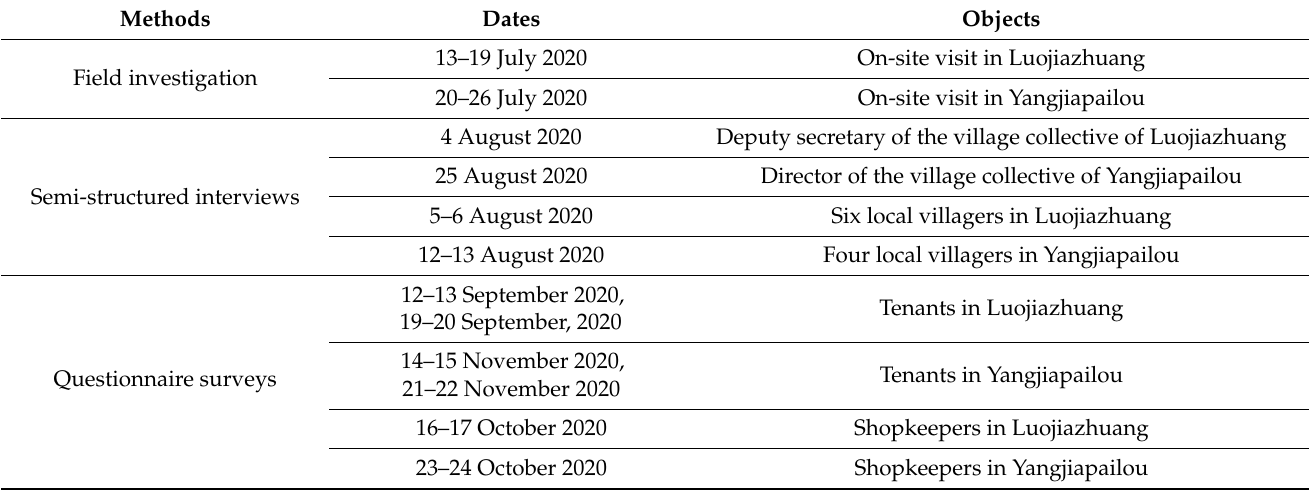
Table 2. Details of the data collection